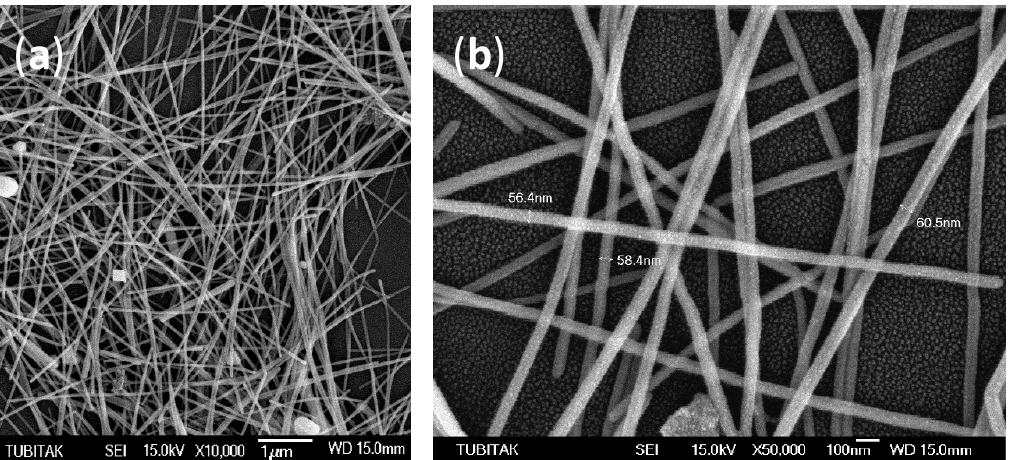
Figure 3. SEM images of silver nanowires (AgNWs): ( a ) the existing nanoparticles among the nanowires; ( b ) the dimensions of the nanowires.